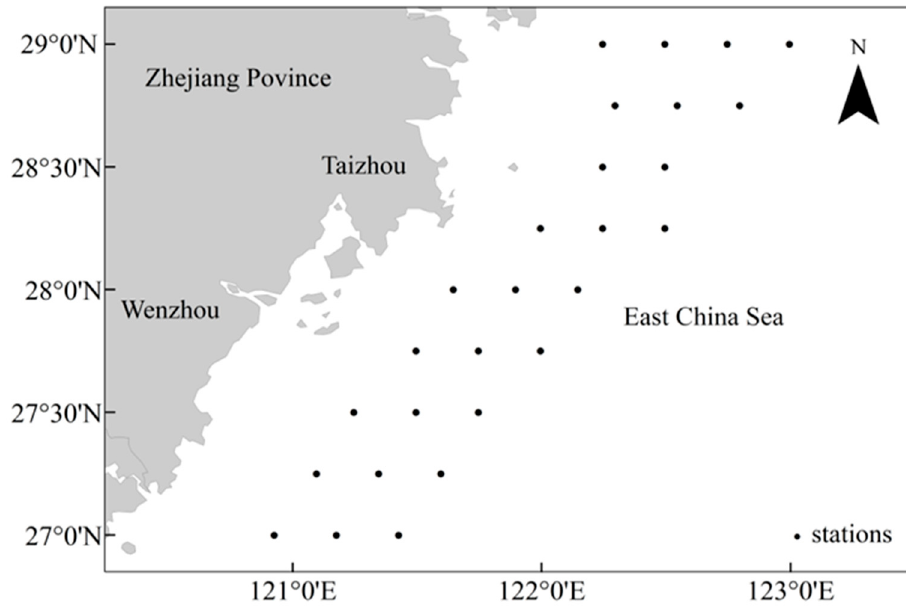
Figure 1. Sampling stations for the distribution of fish resources and hydrological environment sam- pling stations in offshore waters south of Zhejiang. sampling stations in offshore waters south of